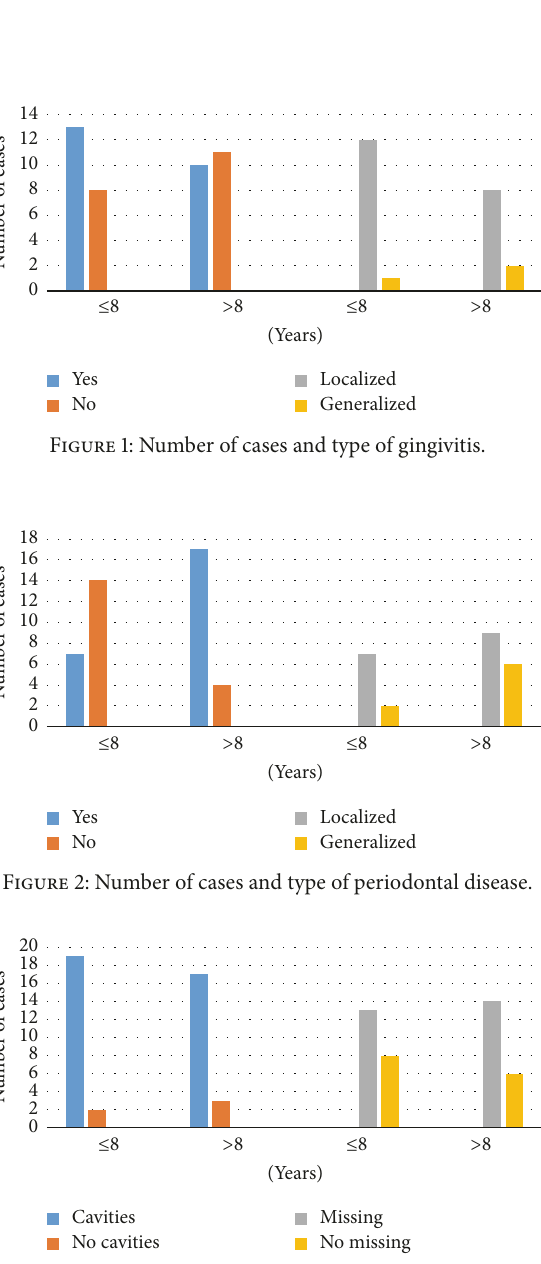
Figure 3: Number of cases with cavities and missing